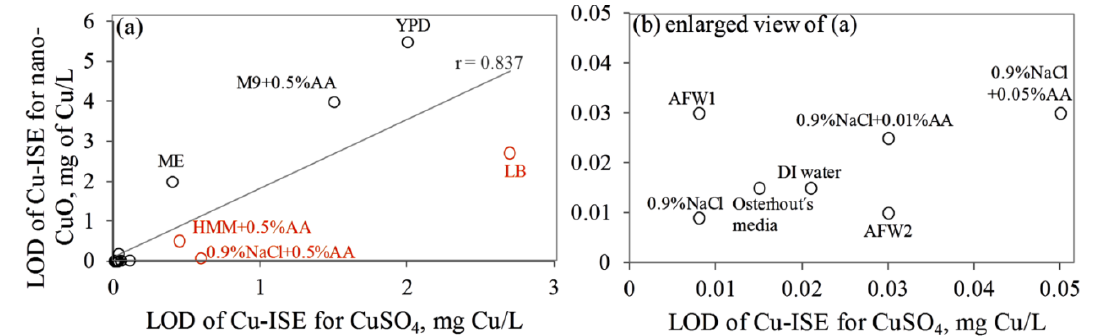
Figure 4. Correlation between Cu-ISE prepared in different ecotoxicological and microbiological media. The names of test media correspond to Table 1; ( b ) is enlarged view of ( a ). Symbols in brown color indicate those media where the concentration of free ions in nano-CuO suspensions was lower than could be predicted from what was observed in case of CuSO